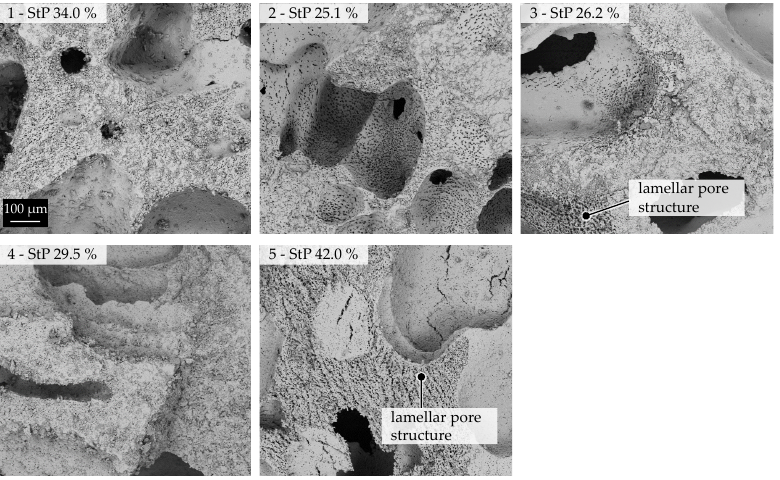
Figure 4. Polished cross-sections at 100 × magnification recorded by FESEM.